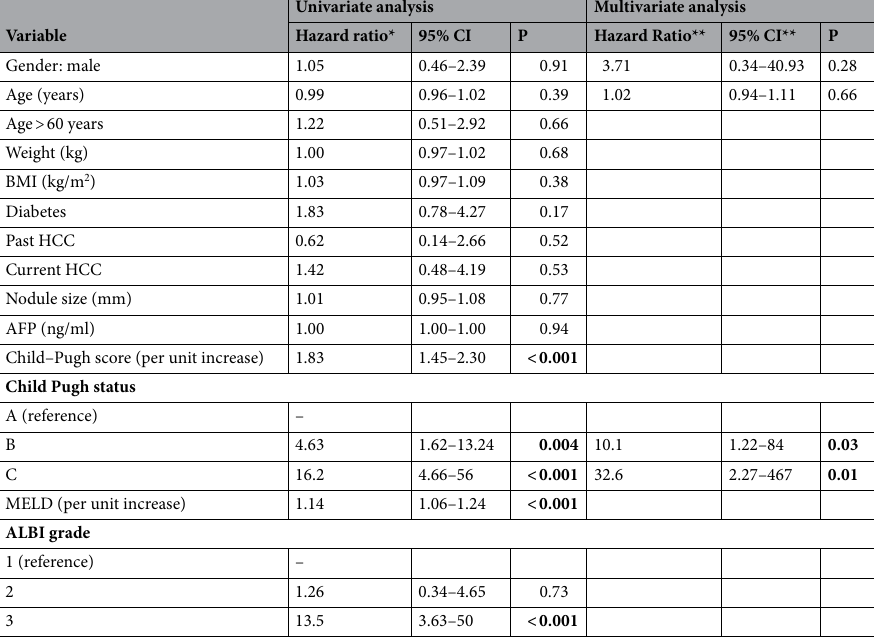
Table 3. Univariate and multivariate analysis of baseline demographic, clinical and nodule characteristics associated with malignant transformation of nodules to hepatocellular carcinoma. *Univariate analysis using Cox regression. **Multivariate Cox model adjusting for age, sex and Child–Pugh Grade. Bold significance P < 0.05.